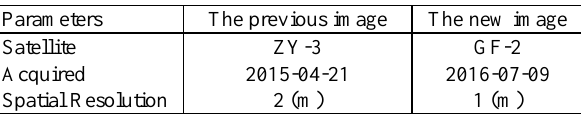
Table 1. The basic information of the image data used in this study